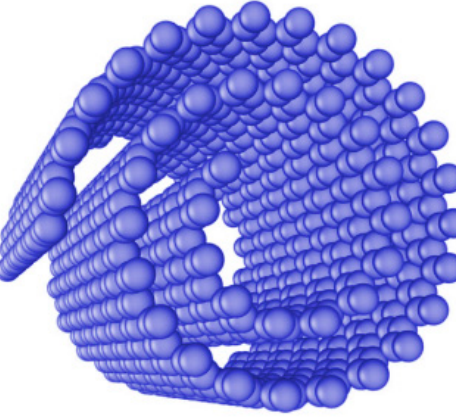
Figure 1. GNS which is made by rolling graphene into a spiral form. Overcoming the chirality and diameter control issues makes the nanomaterial a proper candidate to be utilized in channel of FETs. High carrier mobility in GNS combined with the ability to modulate the carrier concentration causes high field-effect mobility in nanoscale FETs, chiefly those based on low noise and high-frequency operation. Figure 2 shows the scheme of metal-semiconducting-metal (MSM) junctions and a structure of the proposed GNS-based double gate FET with a 20 nm channel length. The width of ribbons and the shape of edges are two important factors in the band gap of GNS. The structure is proposed based on dependence of the energy band gap of armchair GNS on width of ribbon and the shape of its edges. The proposed GNS-FET structure is made from a semiconducting GNS as the channel, and metal GNS as the source and drain contacts, respectively. GNS with extremely thin body thickness allow excellent electrostatic control. Therefore, it can improve the gate control, which is desirable for the ultimately scaled transistor to reduce the short channel effects. It is noteworthy that the gate metal work function is considered so that the zero potential point in the channel stays in the middle of the band gap at an equilibrium condition. The transport properties of GNS nanoribbons can be controlled by the staggered sublattice potential induced by a perpendicular electric field. The required electric field can be produced by applying different voltages to the gate. If the electric field applied is not perpendicular to the GNS layer, the staggered potential is reduced, and a larger electric field is required to produce the same effect on the